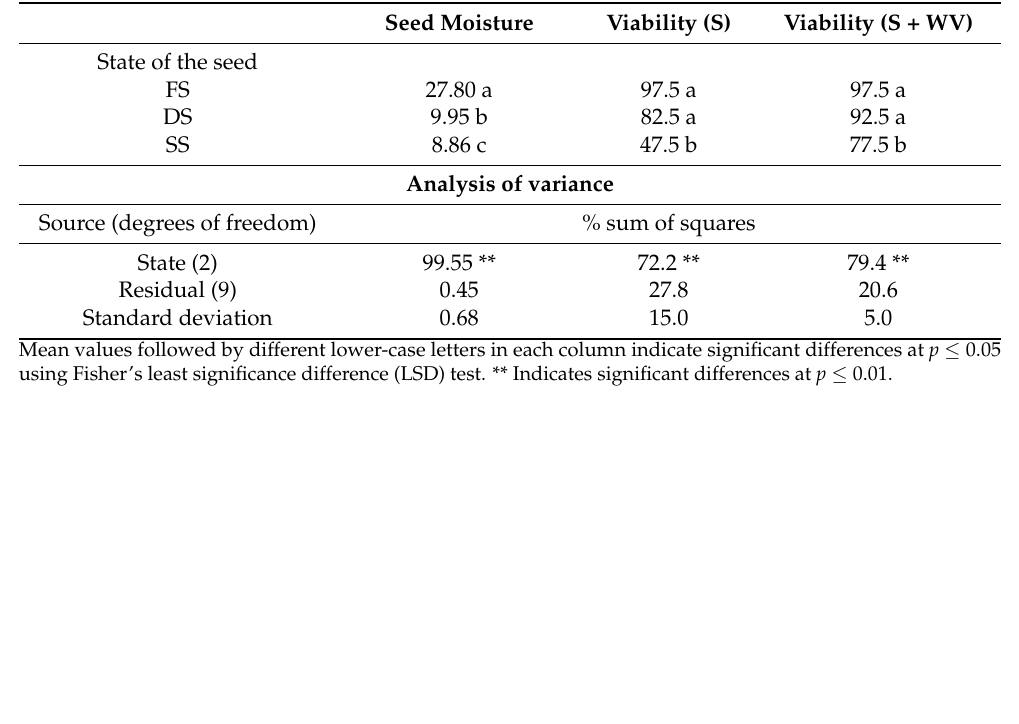
Table 5. Effect of the state of the seed (fresh seeds (FS), dried seeds (DS), and stored seeds (SS)) on the seed moisture content (%) at starting the viability and germination tests and on the viability of the seeds (%), considering both the sound seeds (S) and the sound and weak but viable tissues (S + WV) criteria; mean